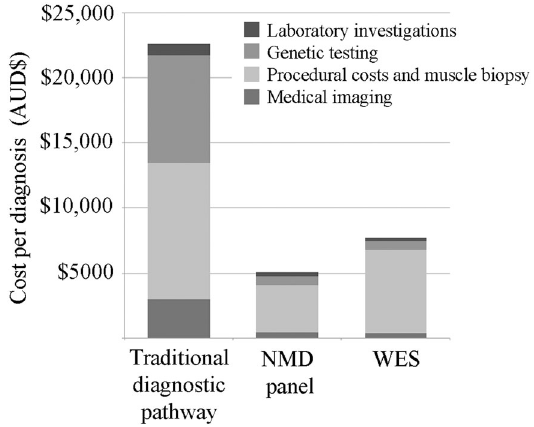
Fig. 3 Cost savings by investigation type. Cost per diagnosis ($AUD) of the traditional diagnostic pathway compared with NMD gene panel and WES. Costs are divided by laboratory investigations, genetic testing, procedural costs, and muscle biopsy and medical imaging, demonstrating cost savings using a molecular approach to diagnosis, predominantly in genetic testing costs and procedural